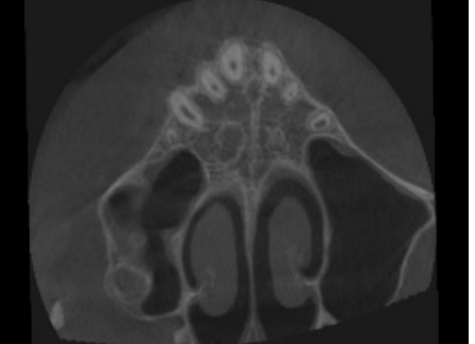
Figure 7. Through CBCT the morphology of the midpalatal suture, can be evaluated. In this case, identified as stage C.